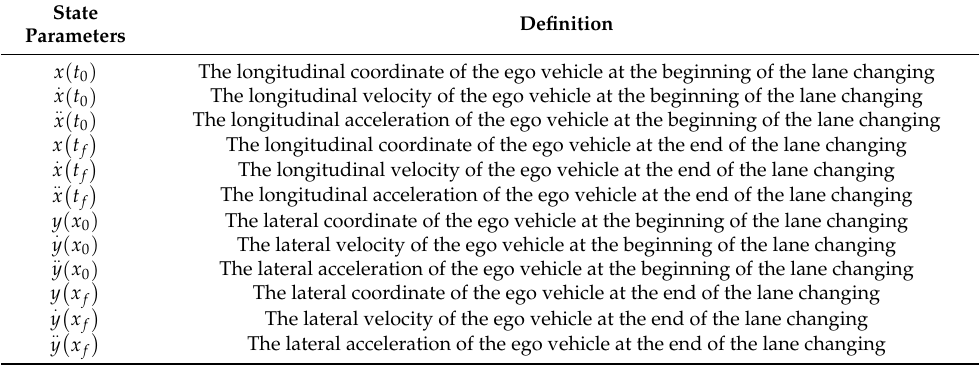
Table 1. State parameters with their